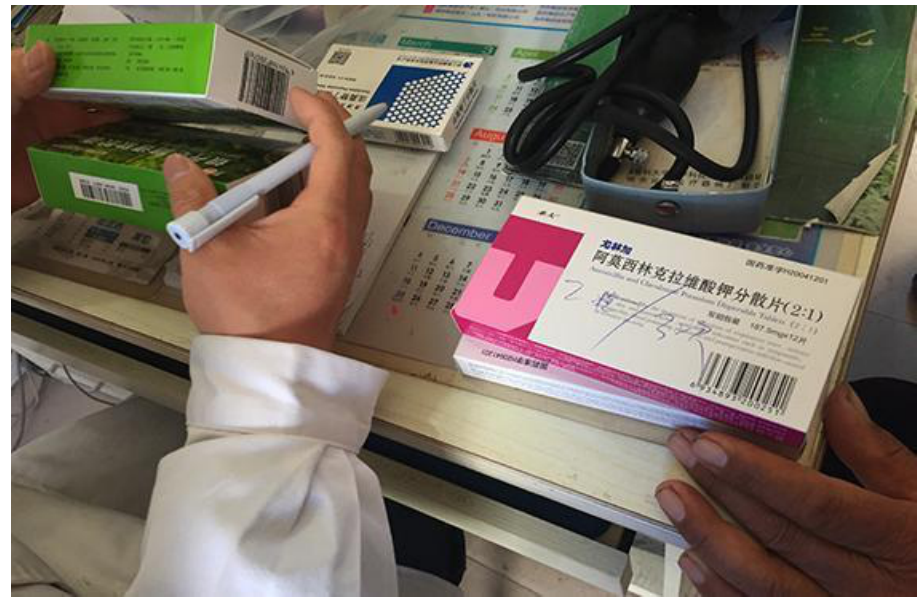
Figure 2. Doctor wrote the dosage